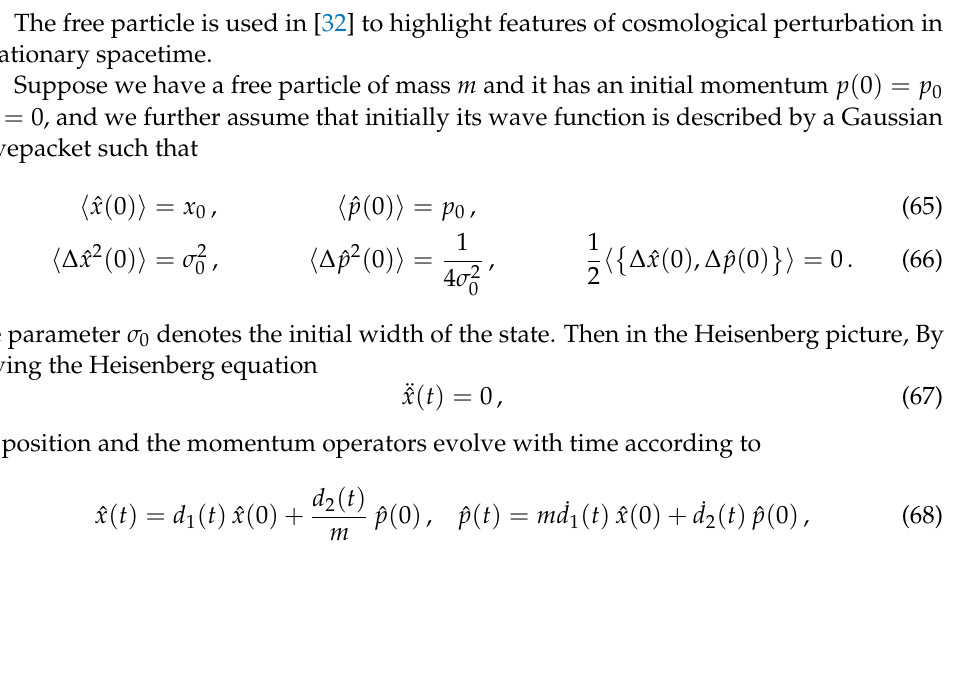
( − 1 ) n and the number of the regions where π ¯ h